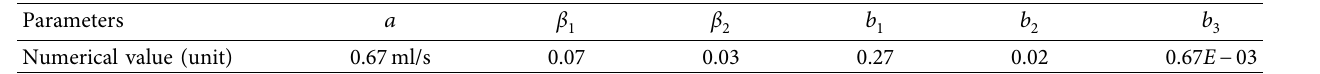
Table 3: Fuel consumption model parameters